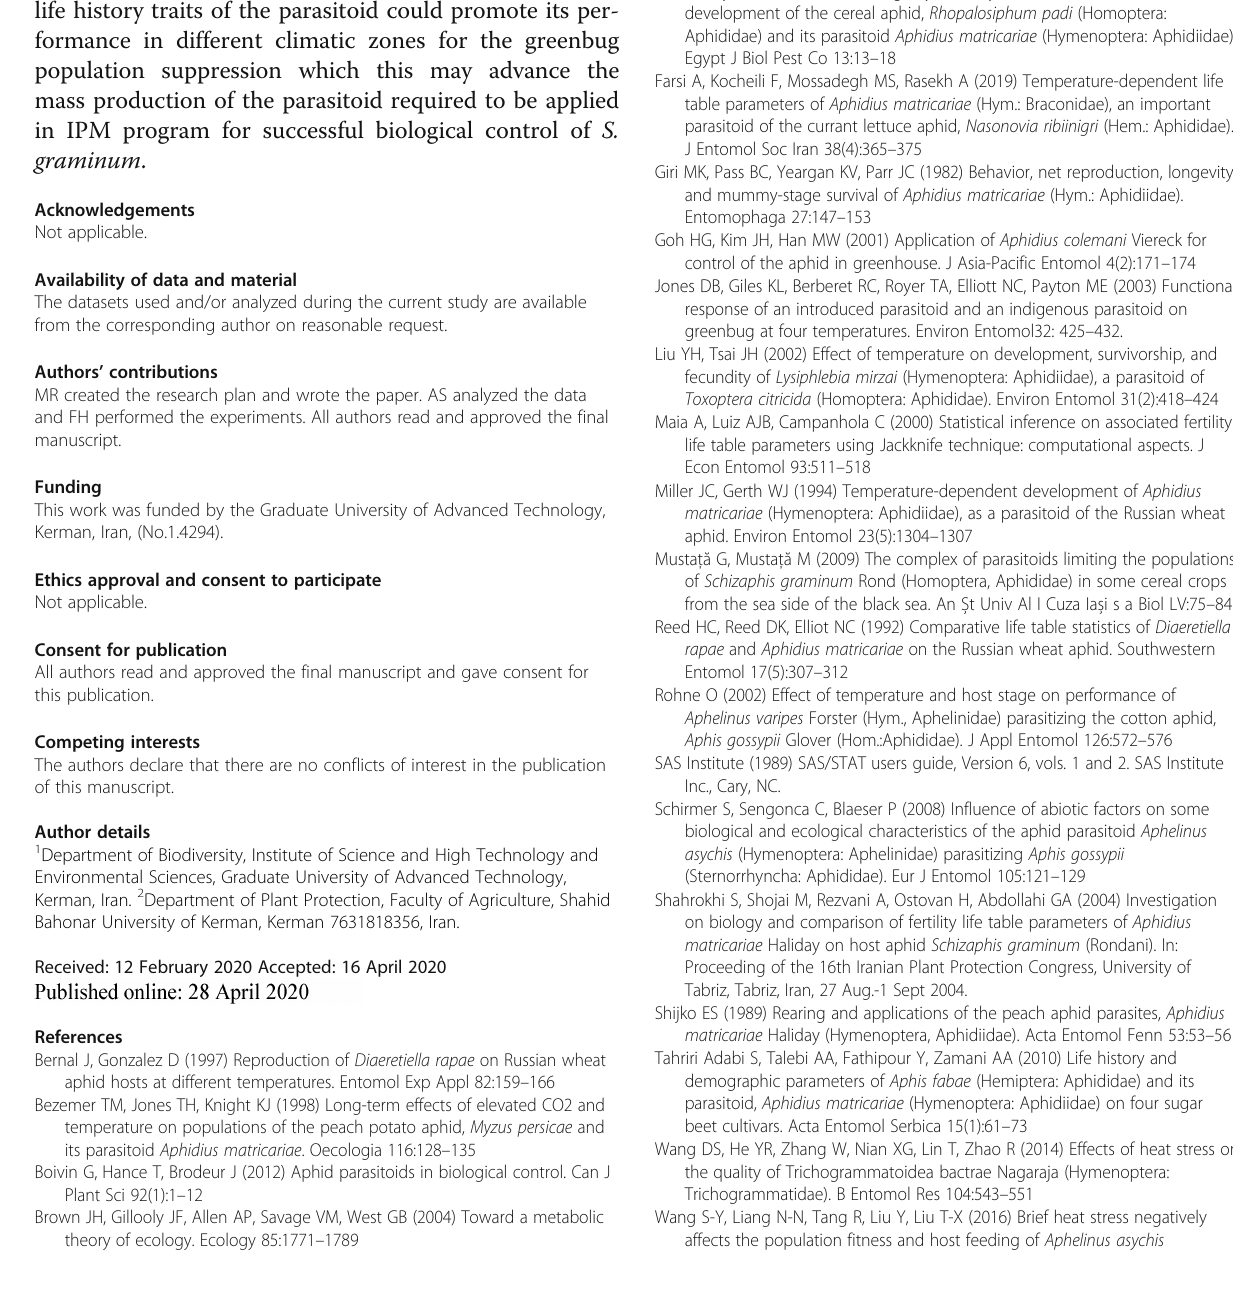
table parameters of Aphidius matricariae (Hym.: Braconidae), an important parasitoid of the currant lettuce aphid, Nasonovia ribiinigri (Hem.: Aphididae). J Entomol Soc Iran 38(4):365 – 375 Giri MK, Pass BC, Yeargan KV, Parr JC (1982) Behavior, net reproduction,